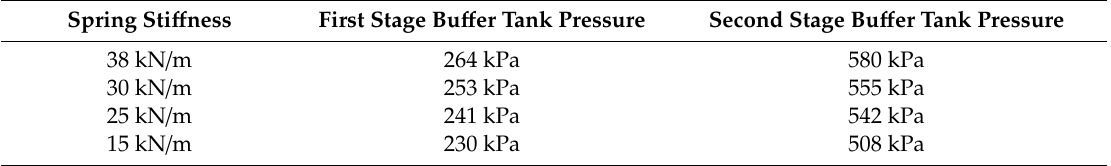
Figure 10. ( a ) First-stage exhaust buffer tank pressure; ( b ) second-stage exhaust buffer tank pressure. Table 3. The pressure varies with the sti ff ness of the Table 3. The pressure varies with the stiffness of the spring.